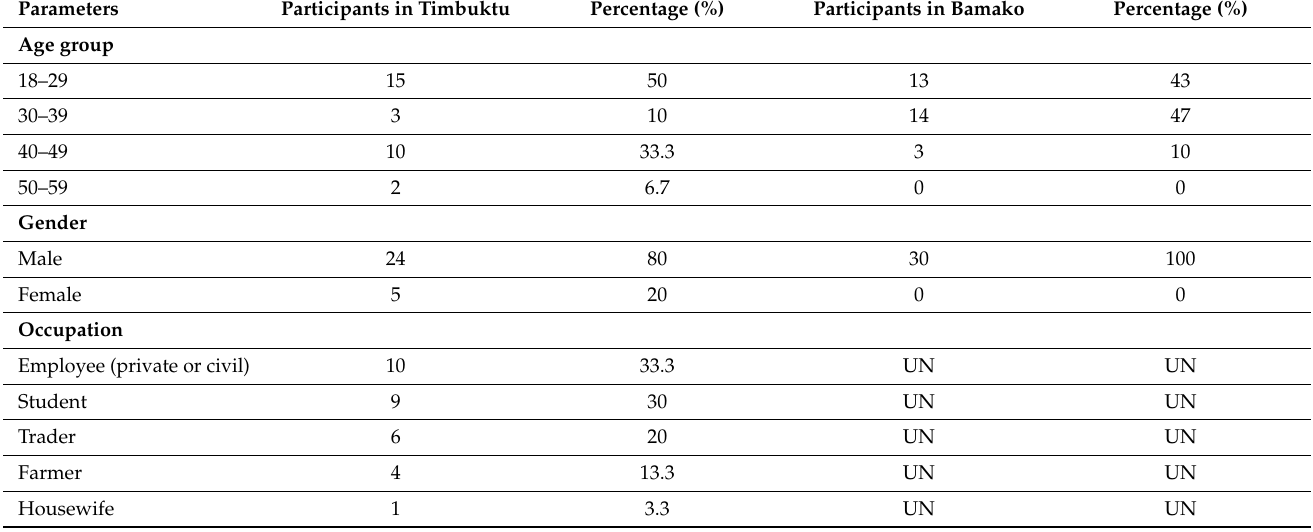
Table 1. Characteristics of the 60 volunteers recruited at the regional hospital of Timbuktu (29